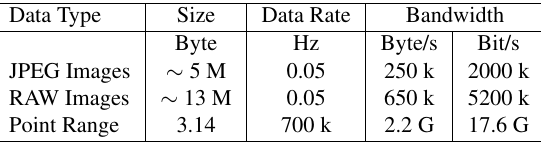
Table 2: Sensors data types and bandwidth requirements